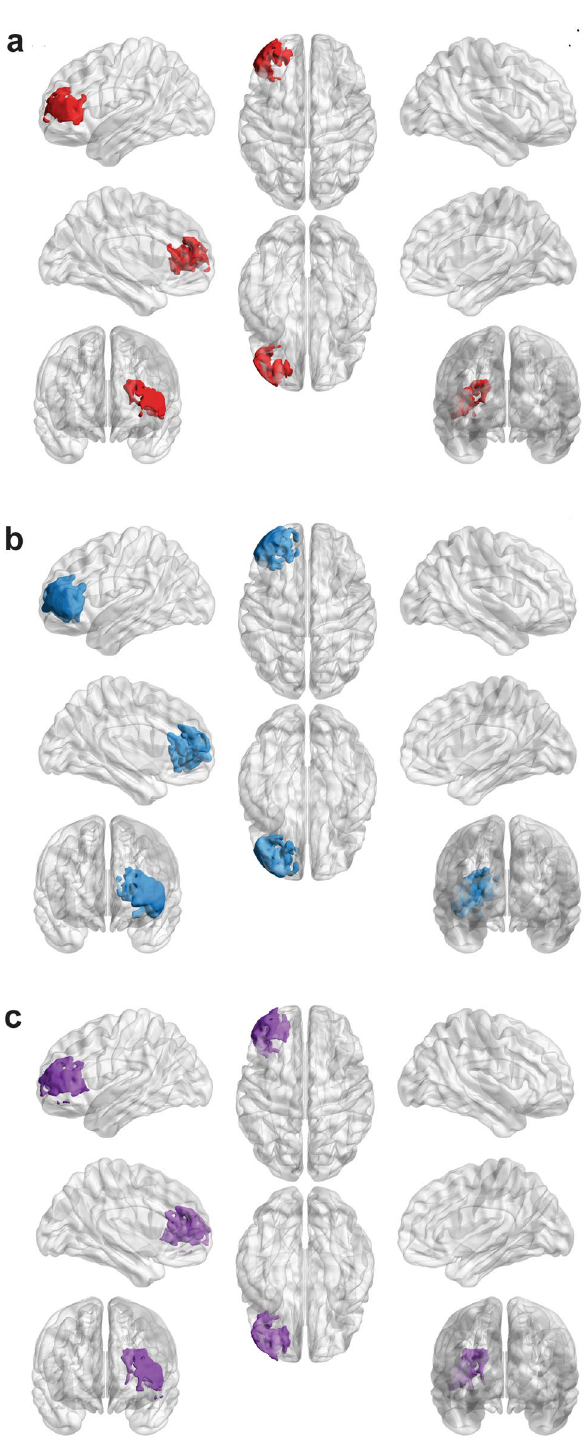
Figure 5. Results of support vector regression lesion-symptom mapping (SVR-LSM) after voxels thresholded at P < 0.005 underwent cluster-level corrections with 10,000 permutations (cluster threshold = P < 0.05). 3-Dimensional models of resulting clusters were generated using the Montreal Neurological Institute template via BrainNet Viewer (https:// www. nitrc. org/ proje cts/ bnv/). a Lesions in a cluster of 8,333 voxels in the left lateral PFC were predictive of impaired picture naming ( P = 0.045). b Lesions in a larger cluster of 21,512 were voxels predictive of impaired auditory naming ( P = 0.0034). Clusters in a and b overlap completely with the cluster in a extending deeper into subcortical regions. c Results of SVR-LSM using the principal component scores for each participant on the first principal component (PC1). This cluster consists of 11,944 voxels ( P = 0.019) and demonstrates overlap with the clusters in a and